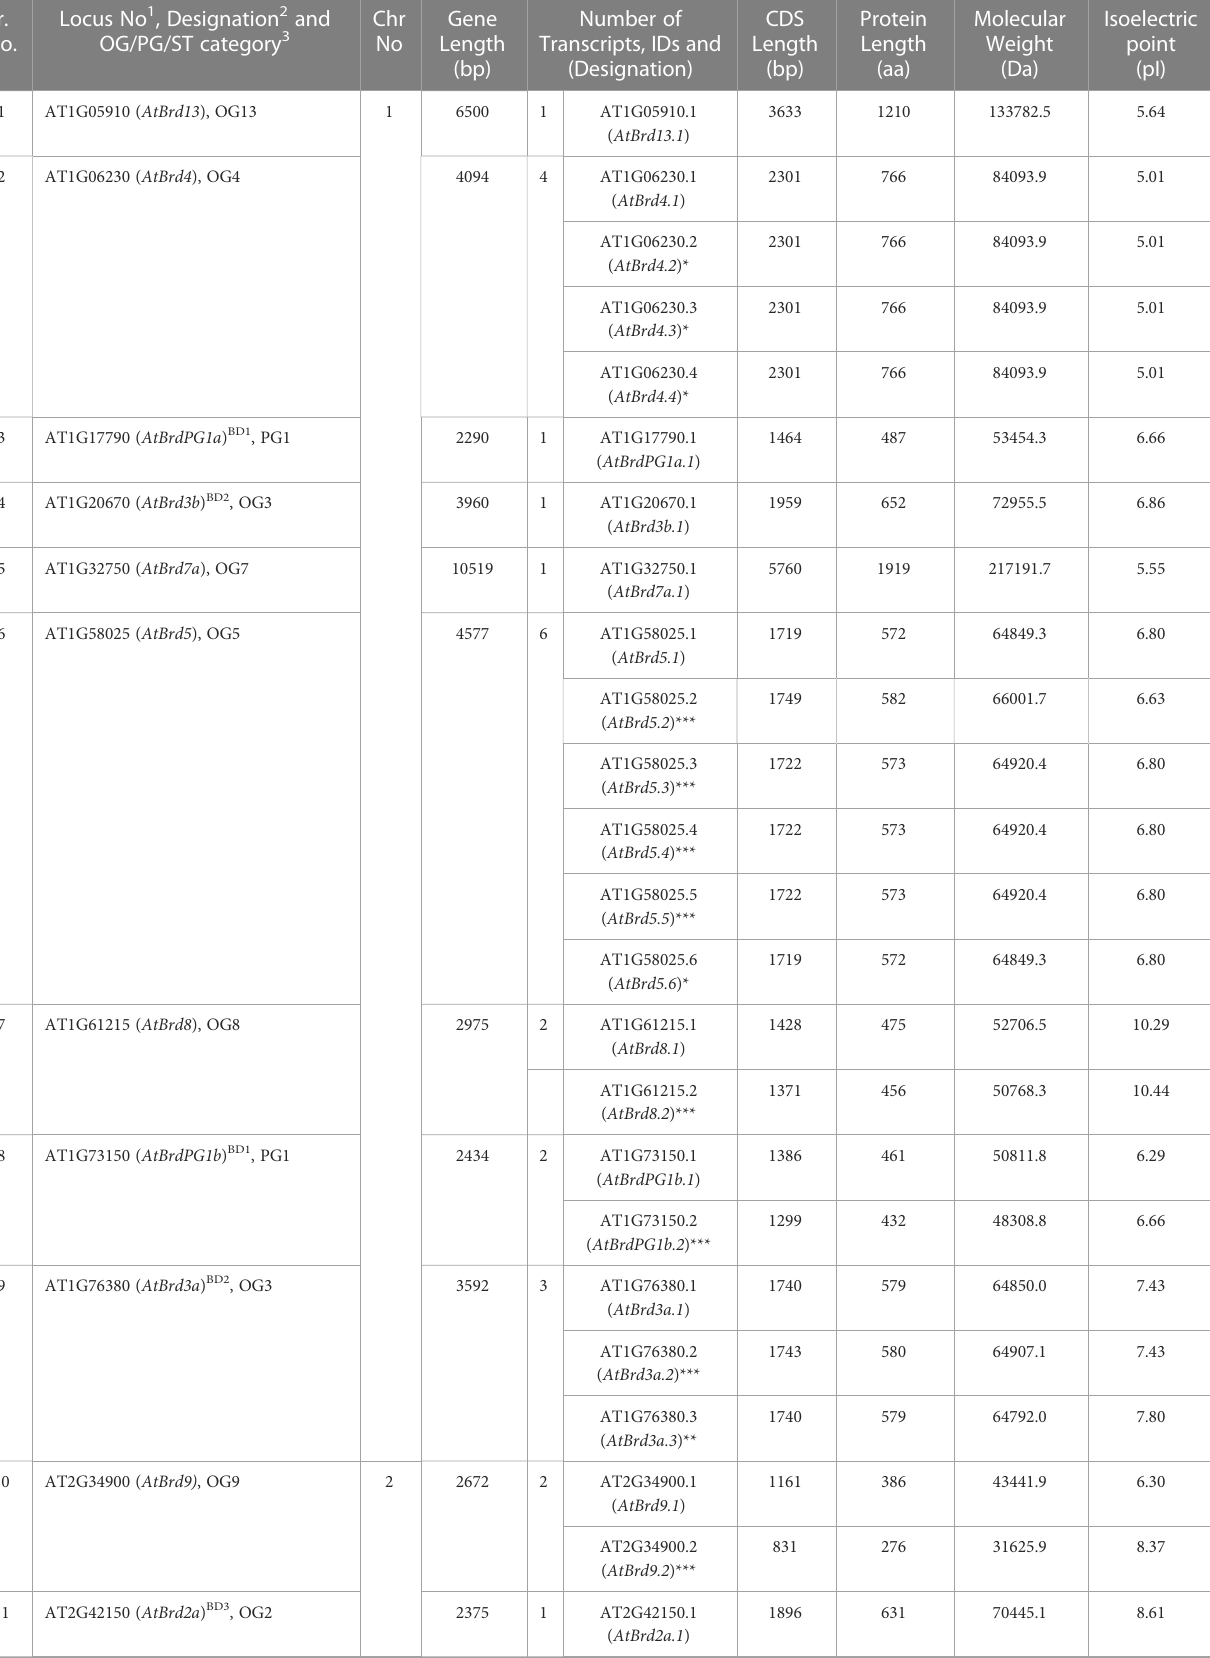
TABLE 1 An overview of characteristics of 28 bromodomain-containing genes ( Brd -genes) in Arabidopsis thaliana genome. Sr.